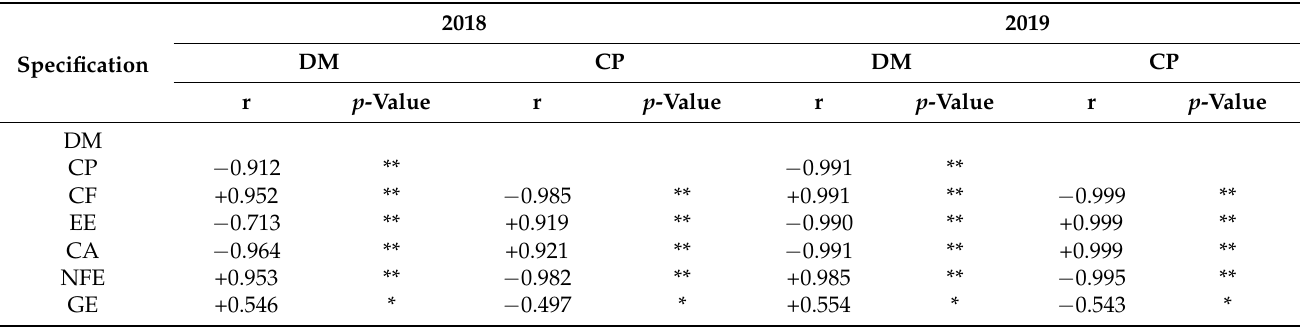
Table 4. Matrix of correlation coefficients between dry matter (DM) and crude protein (CP) vs. chemical